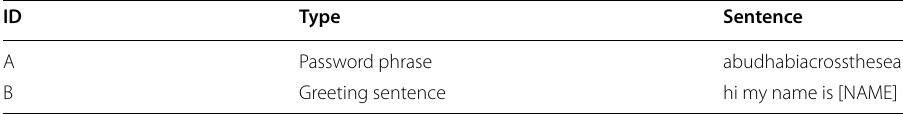
Table 5 Sample groups and predetermined sentence